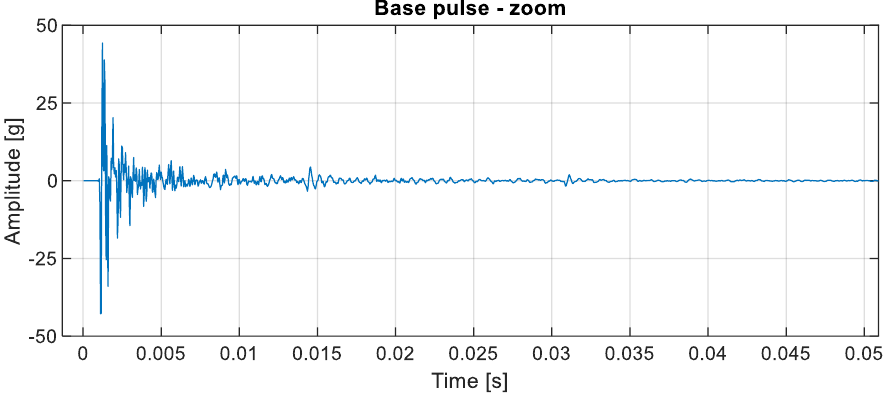
Figure 8. Base pulse — zoom.